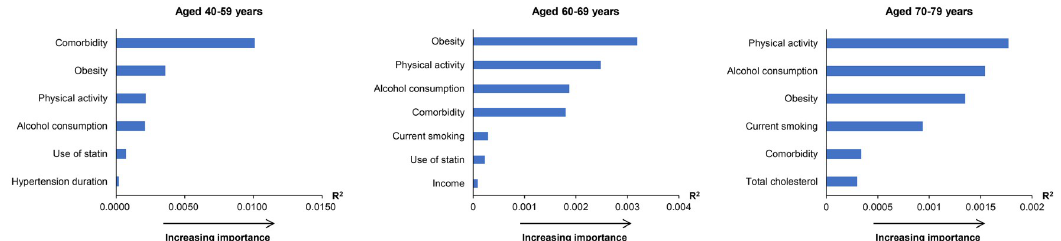
Fig 2. Age-specific relative importance of risk factors for the development of dementia among patients with hypertension: Subgroup analyses by age.